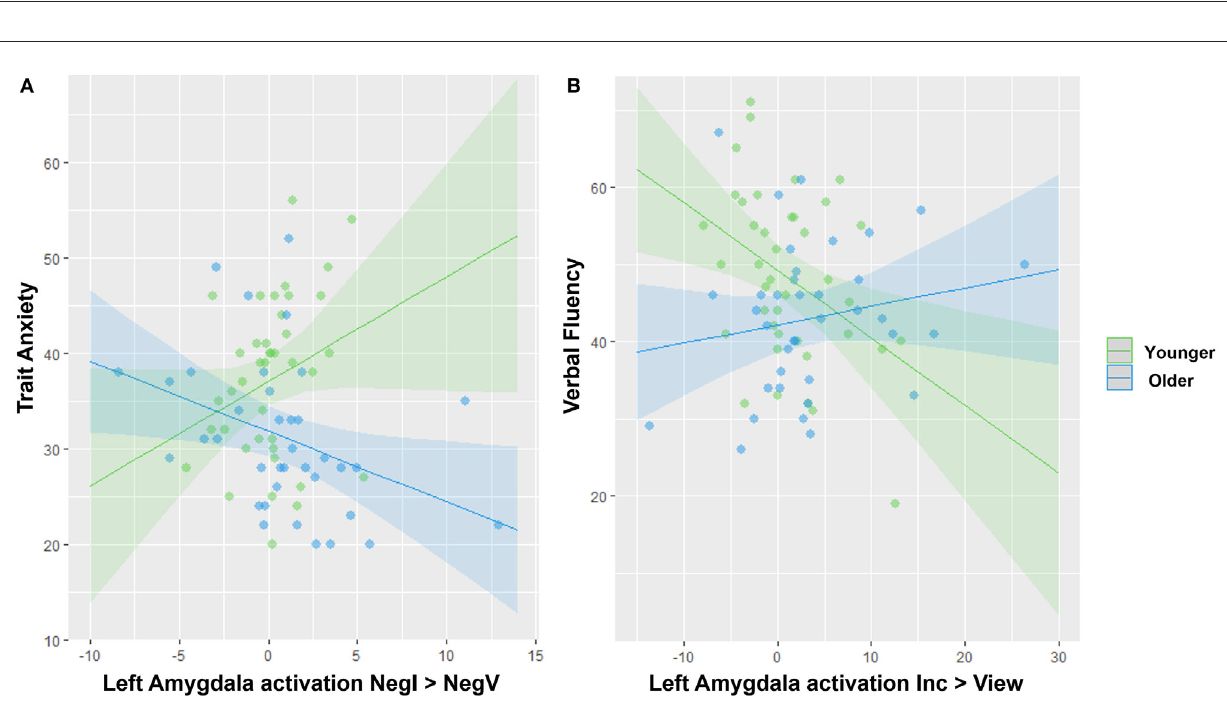
FIGURE4 Significant interactions between age group and amygdala activation to predict anxiety or cognitive traits. (A) Opposite associations between amygdala activation and trait anxiety in younger vs. older adults. (B) Opposite associations between amygdala activation and verbal fluency in younger vs. older adults. Note that removing the two blue outliers in (A) resulted in a stronger age